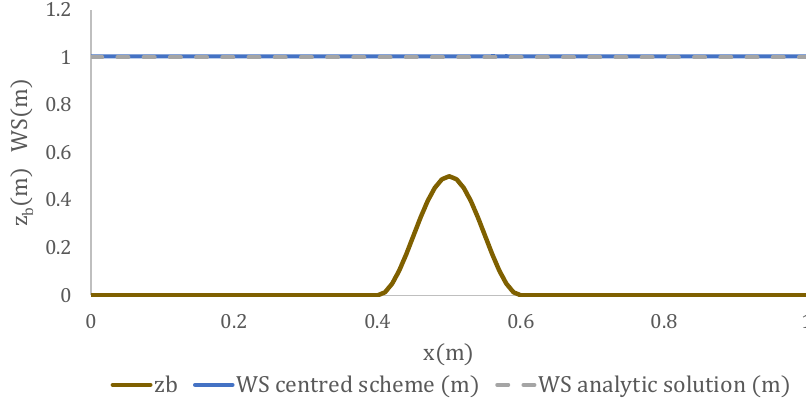
Figure 2. Centred-scheme: WS after 1000 time